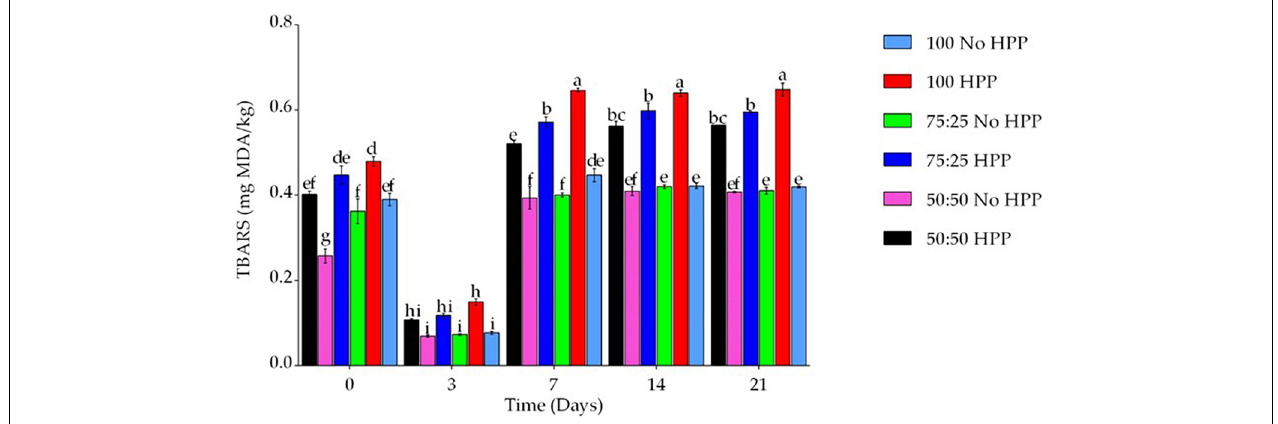
FIGURE 2 | Effect of partial substitution of NaCl in combination with HPP on lipid oxidation marker Thiobarbituric Acid Reactive Substances (TBARS) of beef sausage under cold storage. Data were expressed as mean values and ± SEM. Different lowercase letters indicate significant differences at P < 0.05 in Duncan’s multiple range tests using two-way